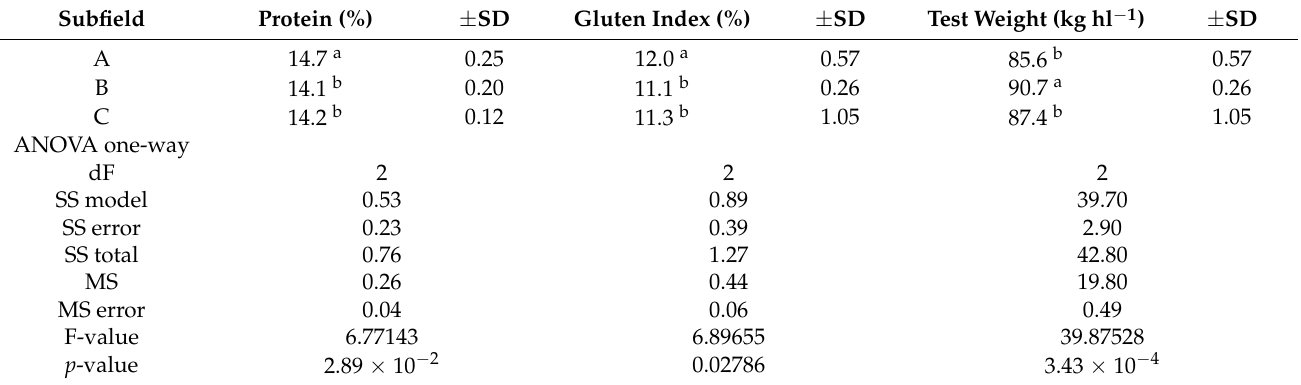
Table 4. Subfields A, B, and C protein (%), gluten index (%), test weight (kg hl − 1 ) data, standard deviation (SD), ANOVA one-way, degrees of freedom (df), sum of square (SS), mean square (MS), F-value, and p -value. For each mean effect, values in a column followed by the same letter are not significantly different at p ≤ 0.05, different letter are significantly different at p ≤ 0.05 as determined by the Fisher test.